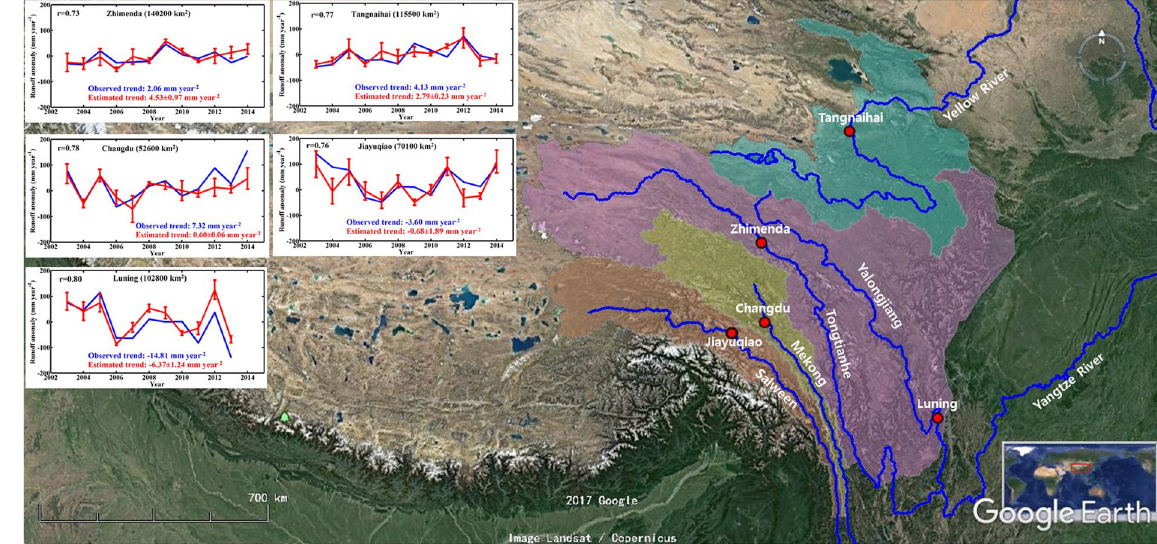
Figure 1. Comparison of observed and estimated Q anomaly time-series at the five gauges. Error bars are standard error generated from the four ET products. Luning basin is short of one year due to data missing. Blue lines are the river network. Red dots are the five streamflow gauges. Two gauges are for the Yangtze River (purple represents the Yangtze River basin) and one gauge is for each of the other three rivers (blue denotes the Yellow river basin, yellow represents the Mekong river basin, and orange the Salween river basin). Coloured area is the extent of eastern TP in this study. The map was generated using Google Earth (v 7.1.7.2606, https://www. google.com/earth/), Image